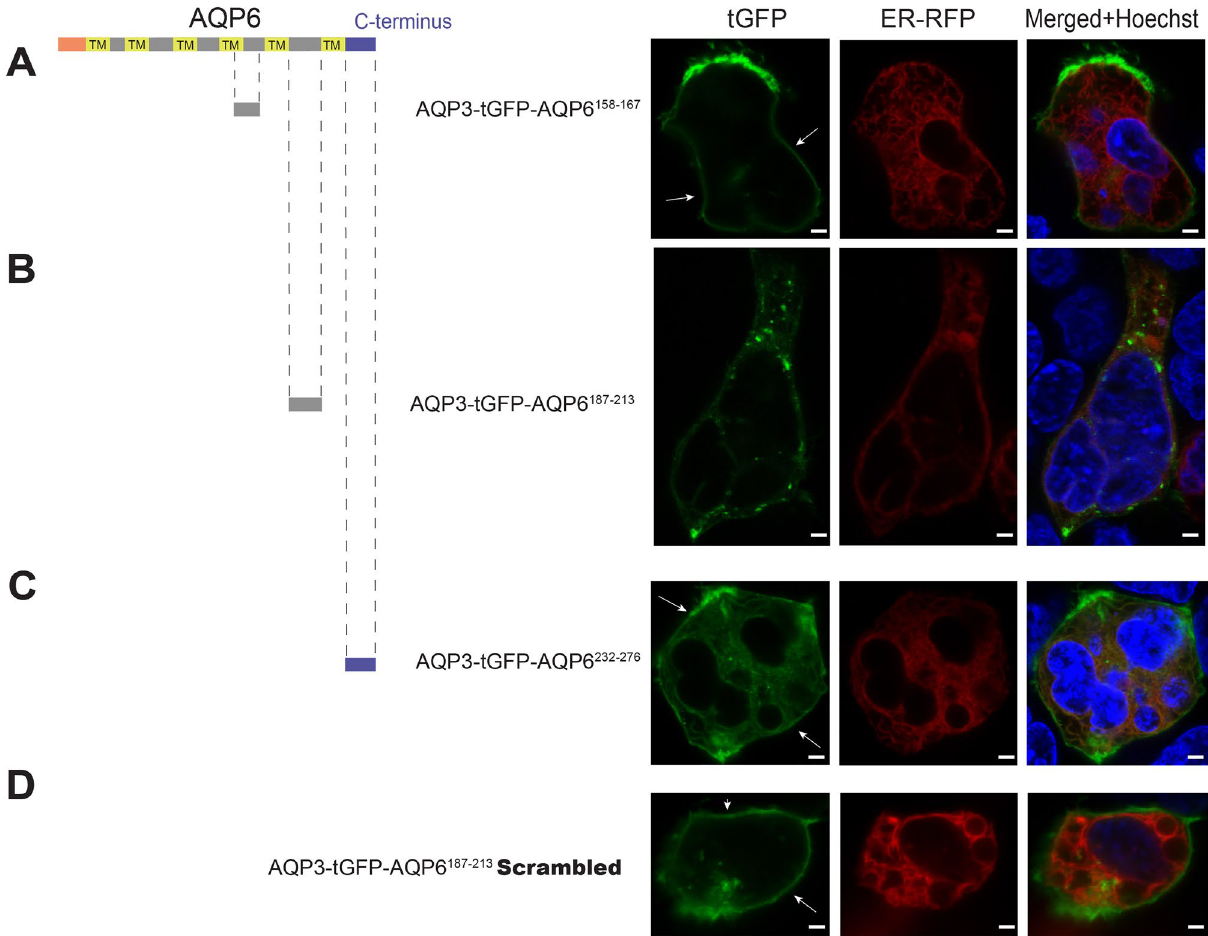
Figure 3. AGR scanning of the second half of AQP6. ( A ) Approaching the second half of AQP6 in a similar manner to Fig. 2, peptide residues AQP6 158–167 when C-terminally attached to AGR results in a construct that reaches the PM (white arrows). ( B ) However, when residues AQP6 187–213 are C-terminally attached to AGR, the construct does not reach the PM . ( C ) Although, AQP6 232–276 residues (compromising AQP6 C-terminal) attached to AGR does localize to the PM. ( D ) Interestingly, when a scrambled version of peptide residues AQP6 187–213 are substituted for the native AQP 187–213 and C-terminally attached to AGR, this construct is able to reach the PM. Cells were observed microscopically using an upright Olympus BX51WI equipped with 100 × 1 NA objective and images were captured using a Grasshopper3 CMOS camera (FLIR, Richmond, BC, Canada) controlled